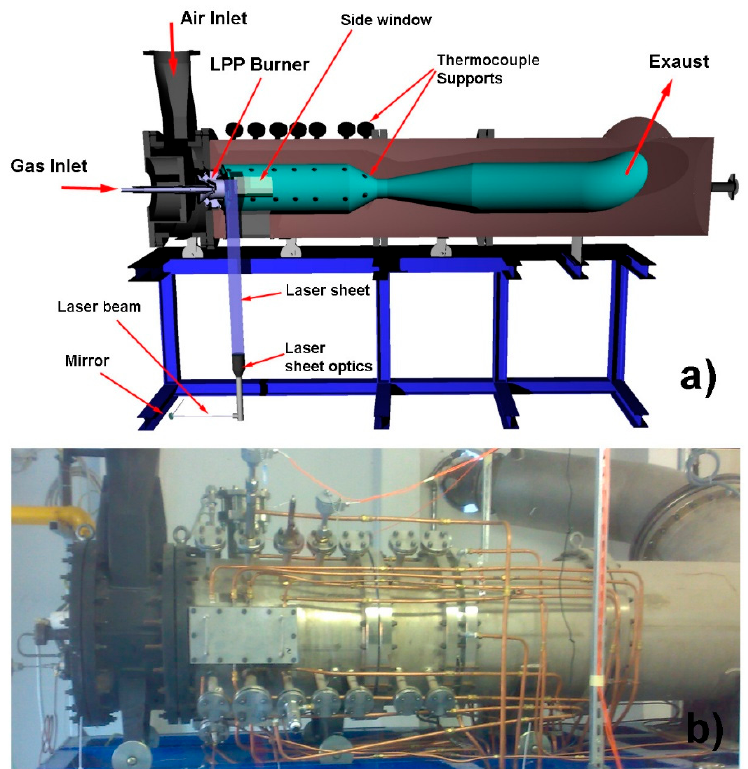
Figure 1. Burner test-rig: ( a ) A section of the rig seen from the right side; ( b ) Picture of the rig seen from the left side where the settling chamber (black section at left end), the test section equipped with physical accesses, and optical windows (blinded in the picture) can be seen.